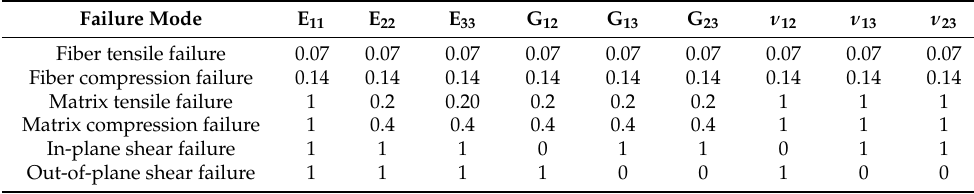
Table 5. Degradation coefficient under different failure modes